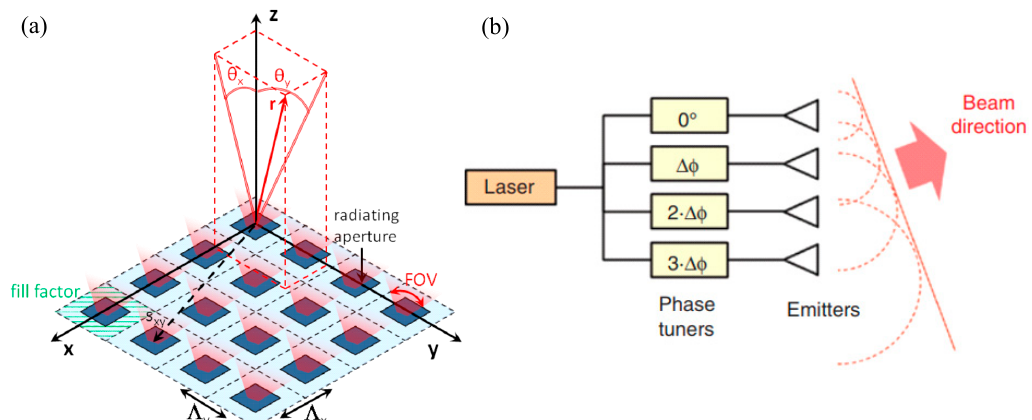
Figure 2. ( a ) Schematic of an OPA based on WGAs. Reprinted with permission from [13], © Gent University. ( b ) An OPA based on EF structures. Reproduced from [18] published by De Gruyter, 2016.